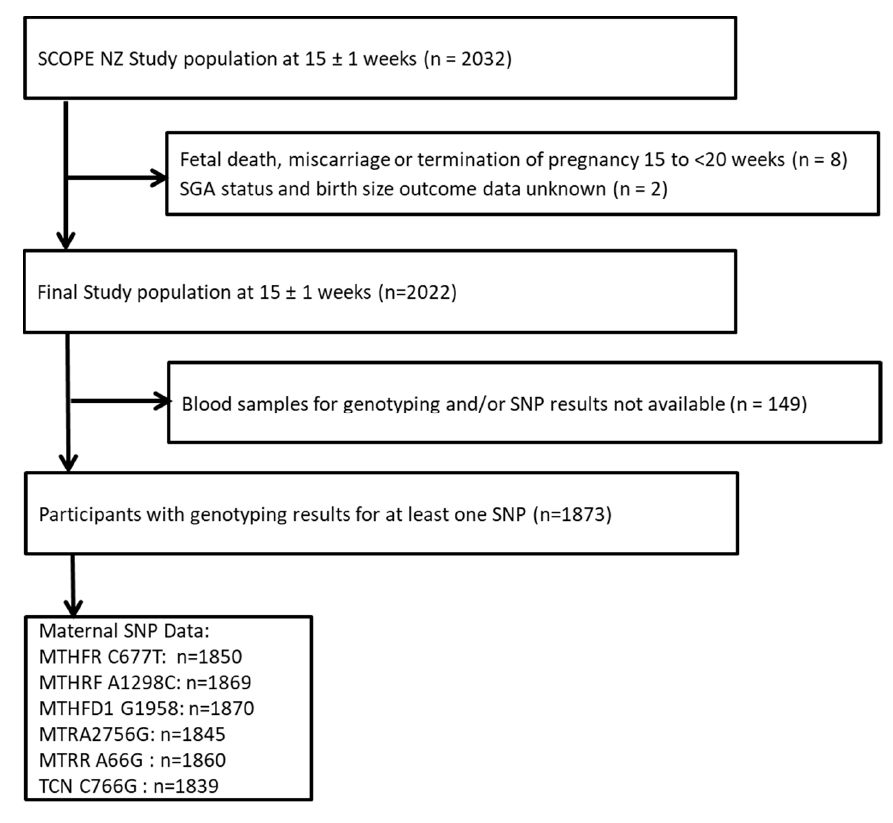
Figure 1. Participant selection flow chart. Table 1. Participant